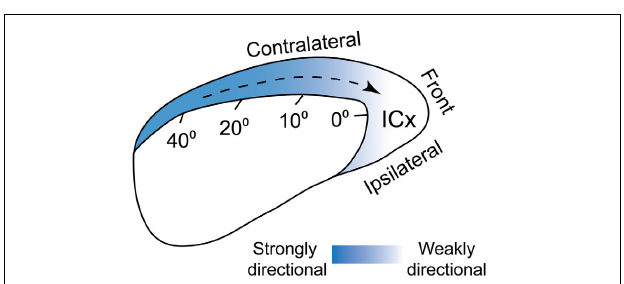
FIGURE 5 | Population-wide directional preference in ICx. ICx neurons prefer sounds moving toward frontal space. This bias in directional preference is stronger for cells tuned to peripheral space and could be mediated both by biased surround suppression and adaptation. From Wang and Pena